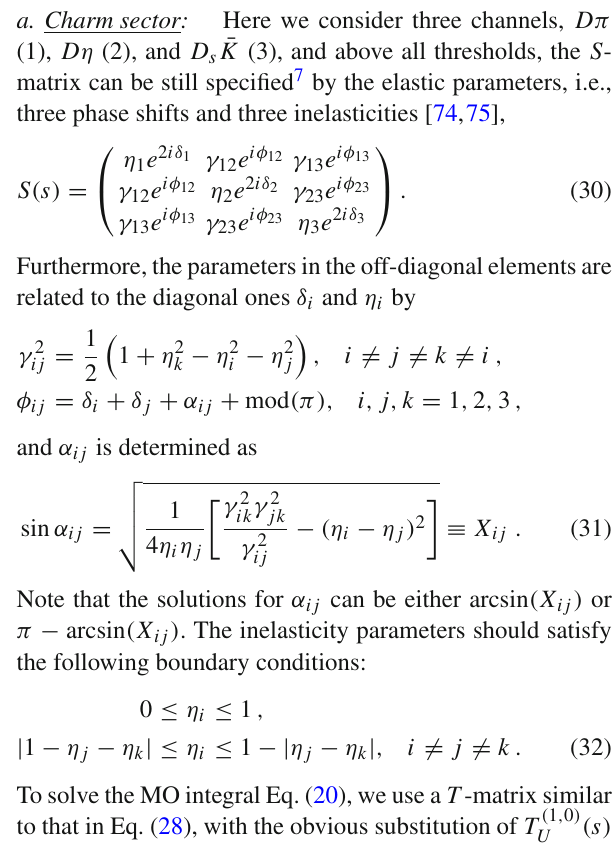
Fig. 3 Phase shifts, inelasticities and amplitude moduli from T Error bands have been obtained by Monte Carlo propagating the uncertainties of the LECs quoted in Ref.